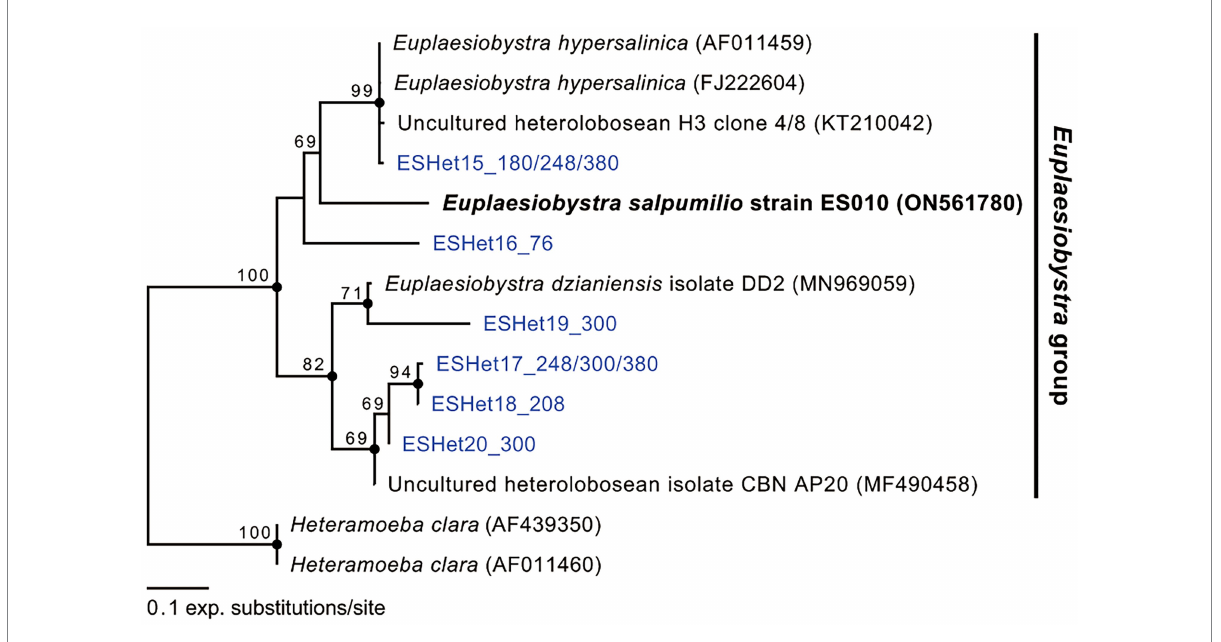
FIGURE 5 Maximum likelihood phylogenetic tree of Euplaesiobystra ingroup, including Euplaesiobystra salpumilio sp. nov. and six uncultured Euplaesiobystra -like sequences (blue) and Heteramoeba clara . Bootstrap support values (>65%) are shown at the nodes. Solid circles represent a Bayesian posterior probability of 1 (posterior probability <0.95 not